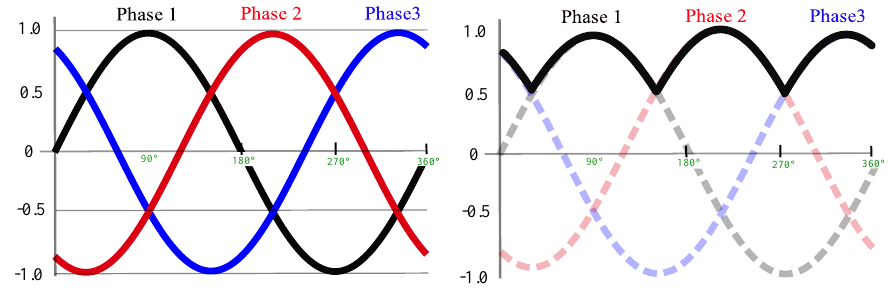
Figure 4. Three − phase half-wave rectification.